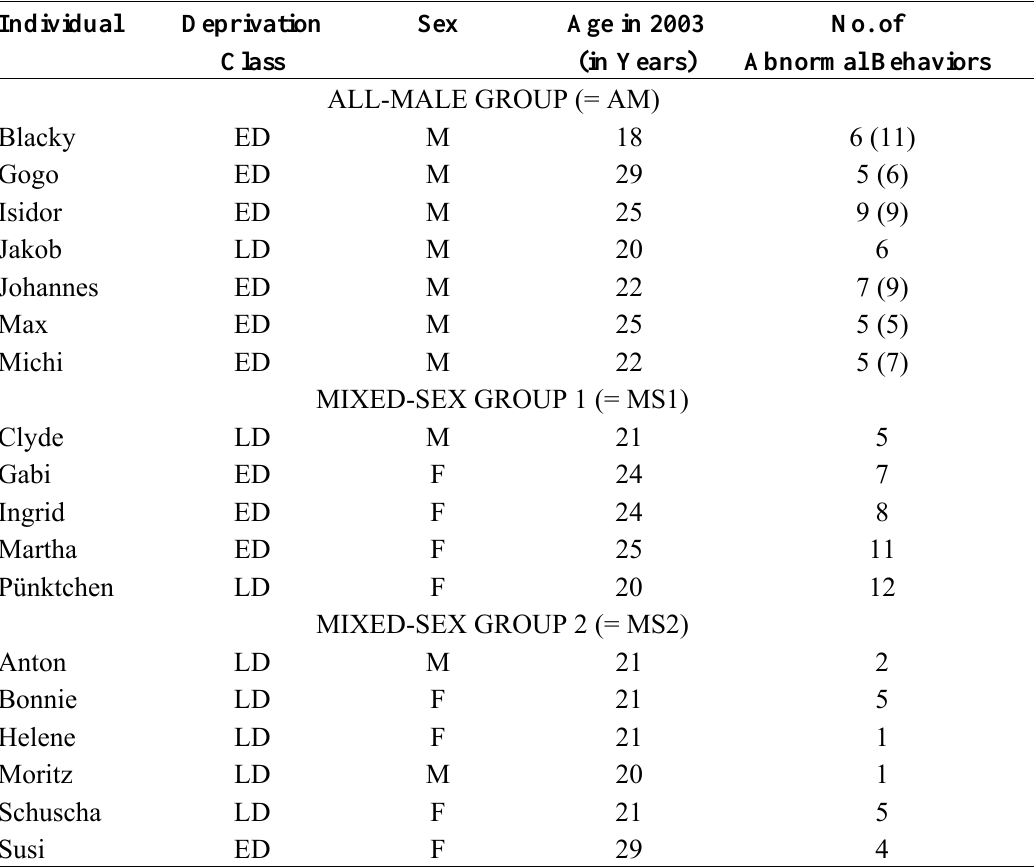
Table 4. (a) Diversity of abnormal behaviors, i.e. , the total number of different abnormal behaviors per individual shown between 2003 and 2005. (b) Number of persistent abnormal behaviors per individual, i.e. , the number of abnormal behaviors that occurred at all three sample